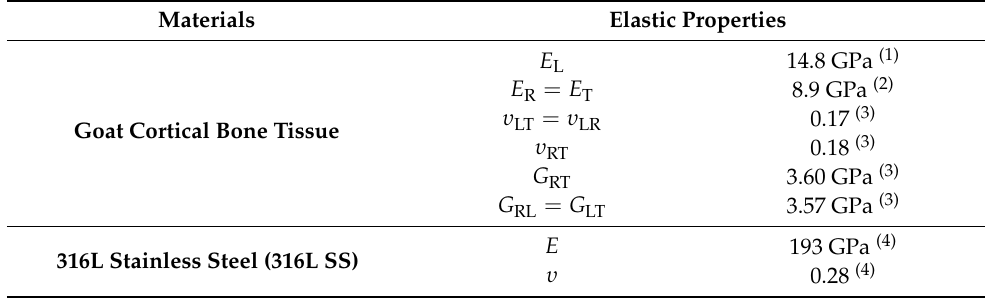
Table 1. Elastic properties used in numerical